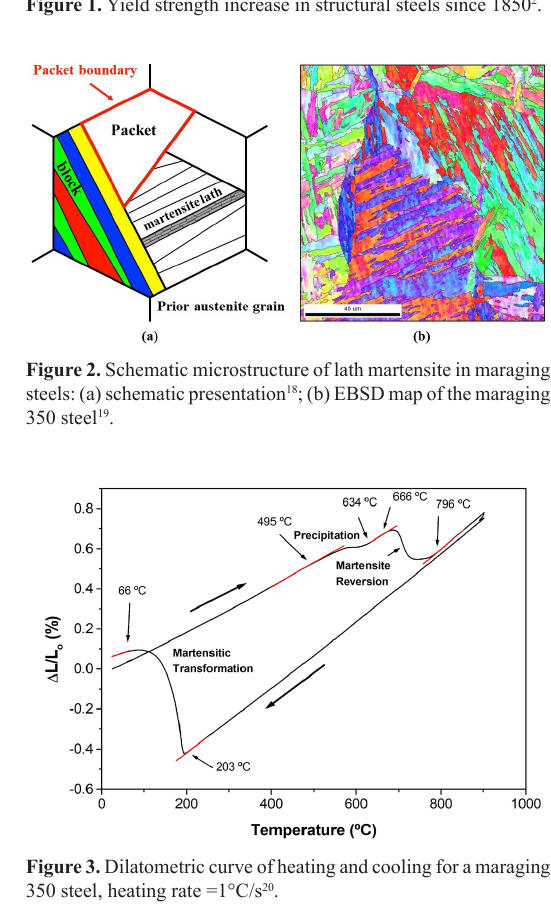
Figure 1. Yield strength increase in structural steels since 1850 2 .